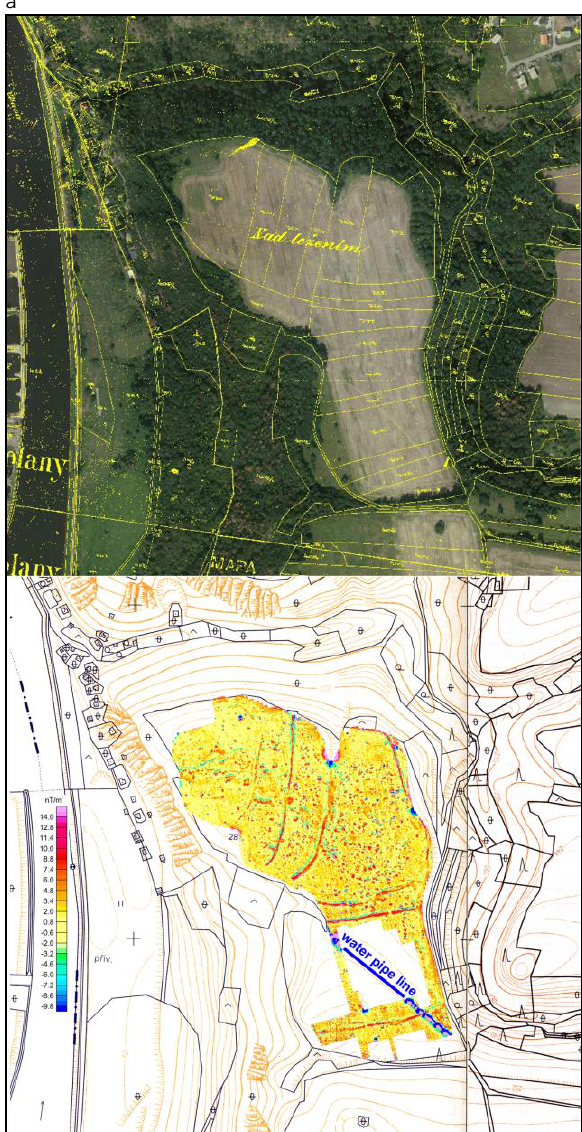
Figure 4. Zlončice, district Mělník. Comparison of aerial photograph of promontory from 2010 in combination with data of the land register (from the middle of 19th century) and result of magnetometric survey (source of aerial photograph: www.kontaminace.cenia.cz; surveyed area: approx. 9.5 ha; geophysical survey: Křivánek